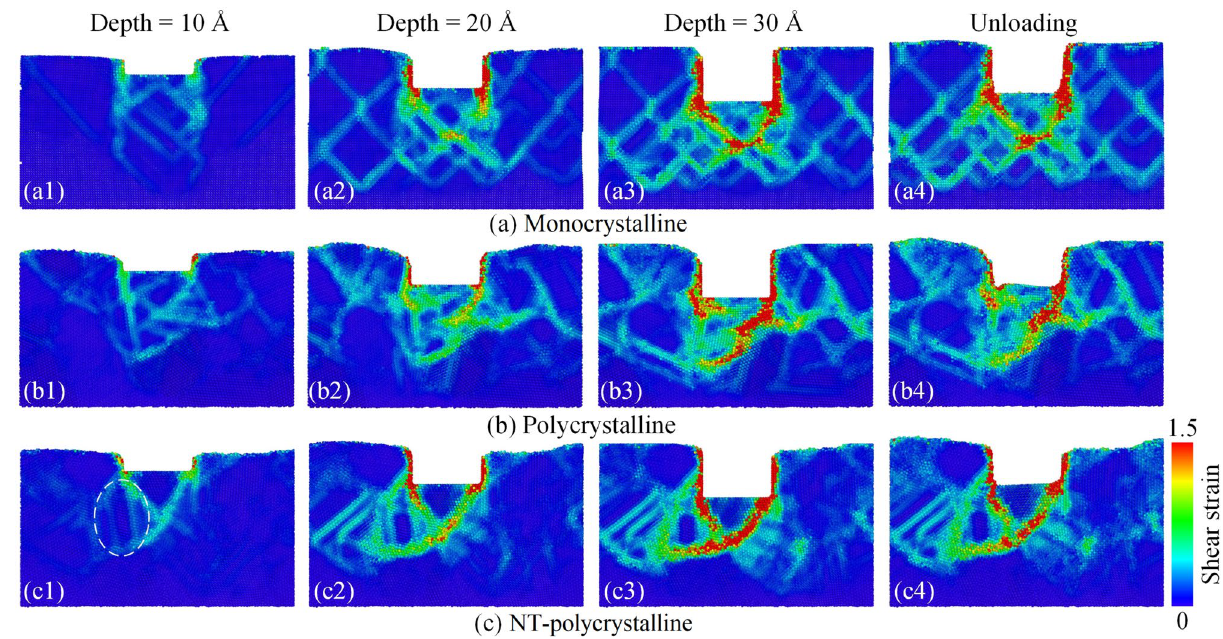
Figure 3. The cross-section of atomic shear strain distributions at the various imprinting depths and unloading stage of the Al0.5 HEA for different structures: monocrystalline ( a1 – a4 ); polycrystalline ( b1 – b4 ); and NT-polycrystalline ( c1 – c4 ).